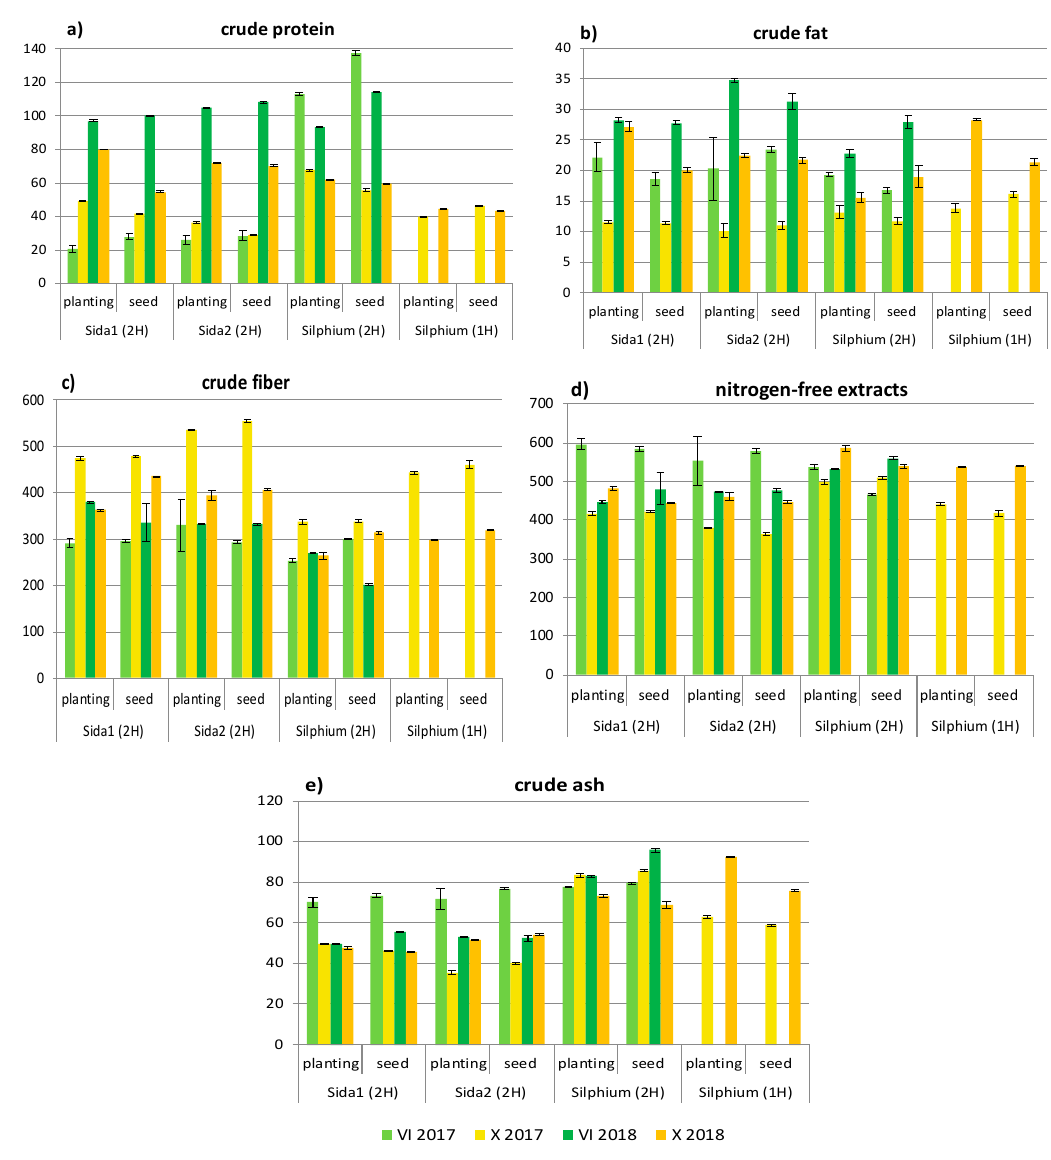
Figure 1. Elemental chemical composition g (kg DM) − 1 of the analysed crop biomass with two Sida phenotypes—Sida1 and Sida2—and Silphium.